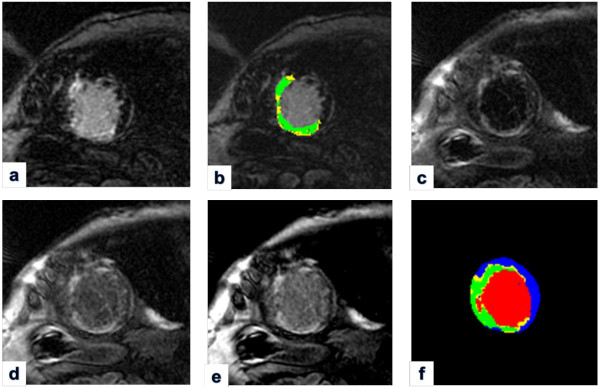
IR-FGRE vs. MCLE peri-infarct GZ map. a: IR-FGRE image; b: Peri-infarct GZ map corresponding to a; c-e: 3 MCLE images at varied TI; f: Peri-infarct GZ map from MCLE: yellow color indicating peri-infarct GZ, green color indicating core MI, red color indicating blood pool, and blue color indicating healthy myocardium.